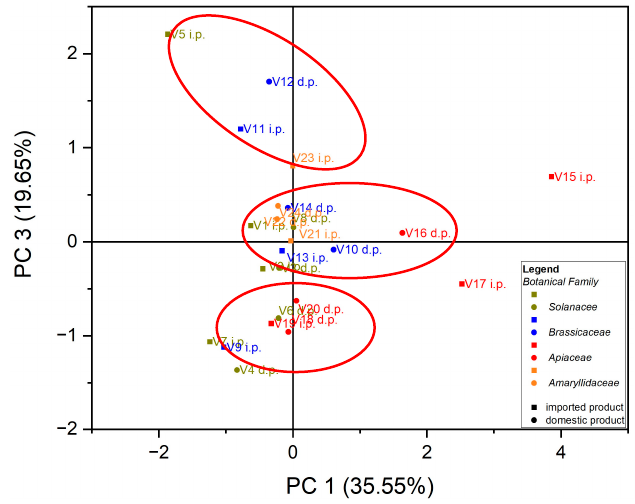
Figure 1. Chart of scores for PC3 vs. PC1 for PCA analysis, using as input data the content of macro elements for the analyzed vegetable samples.